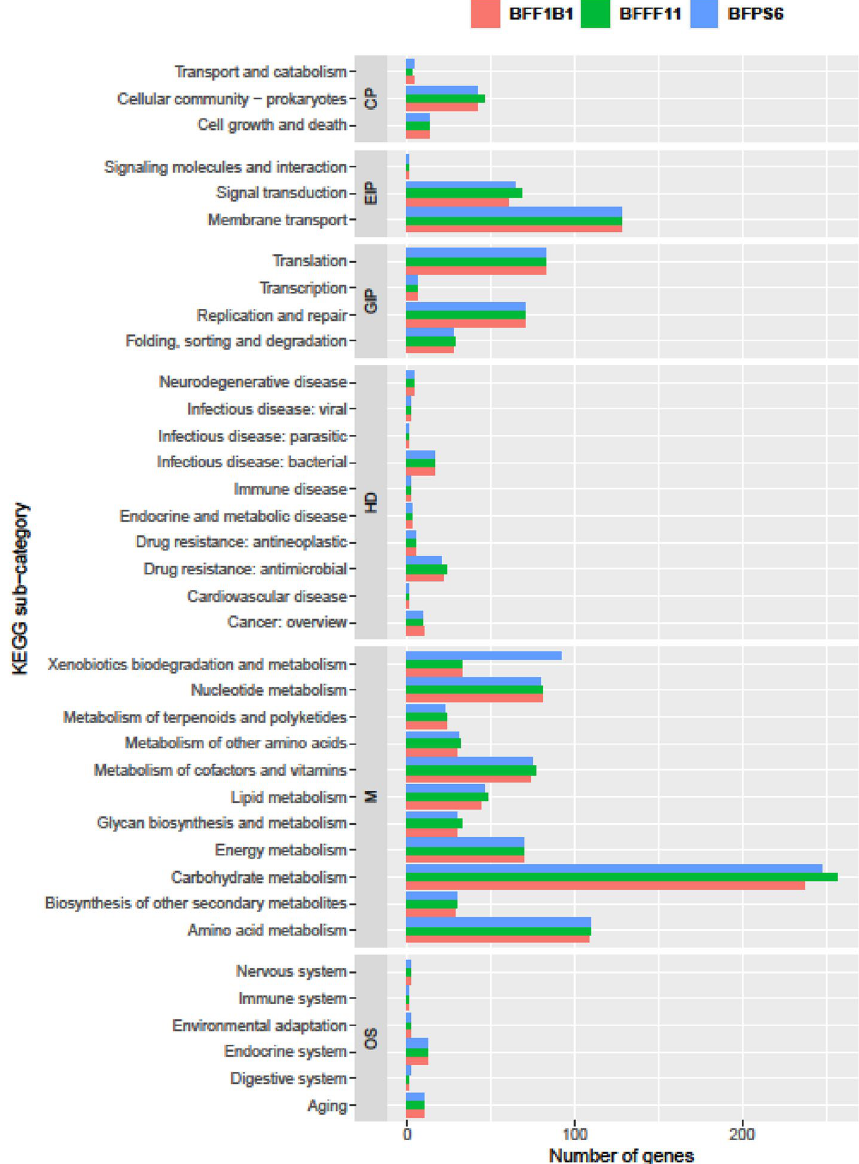
Figure 1. The number of genes categorized by KEGG functional annotation of E. faecalis strains BFF1B1, BFFF11 and